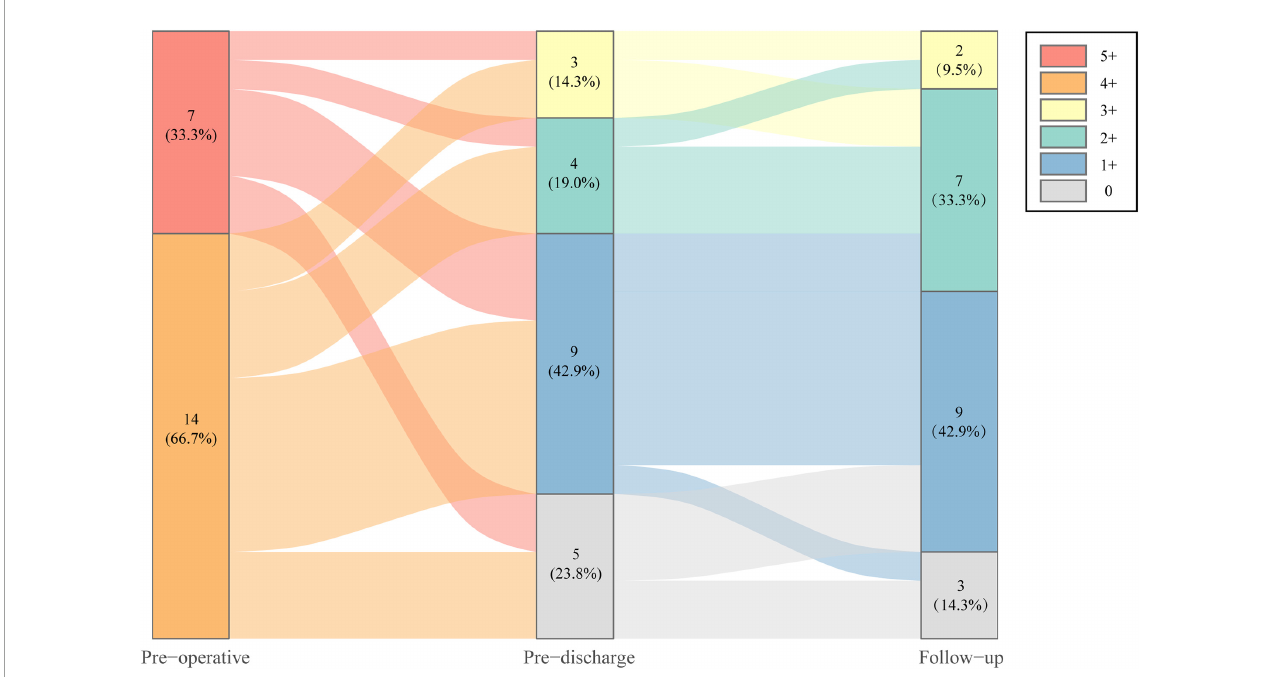
FIGURE2 Severity change of tricuspid regurgitation of study population at preoperative, pre-discharge, and